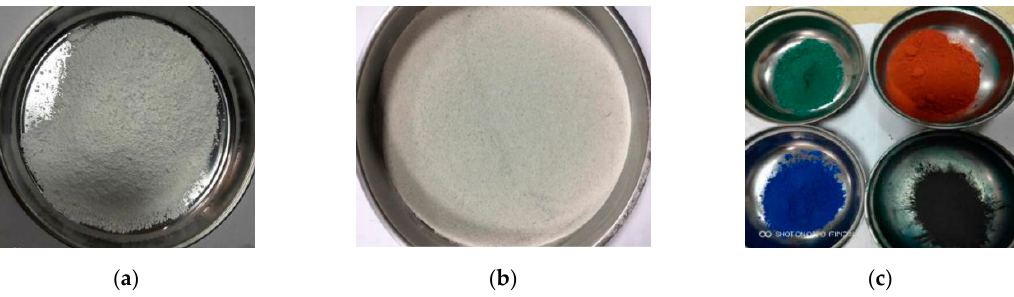
Figure 4. Functional fillers: ( a ) Titanium dioxide; ( b ) Floating beads; ( c ) Inorganic color pigments.